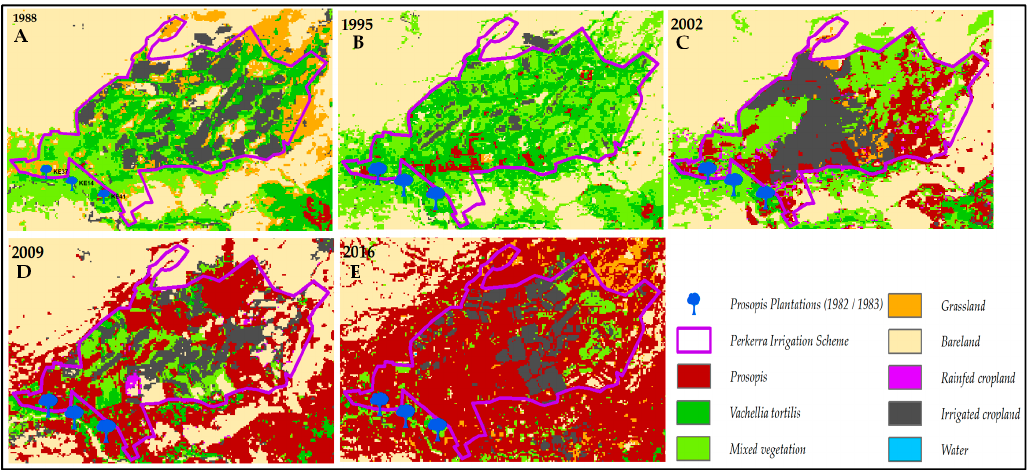
Figure 7. Sequence of LULC maps of Perkerra irrigation scheme showing Prosopis introduction (three plantations) at the southwestern border of the irrigation scheme and its subsequent spread into the irrigation scheme over time ( A – E ).